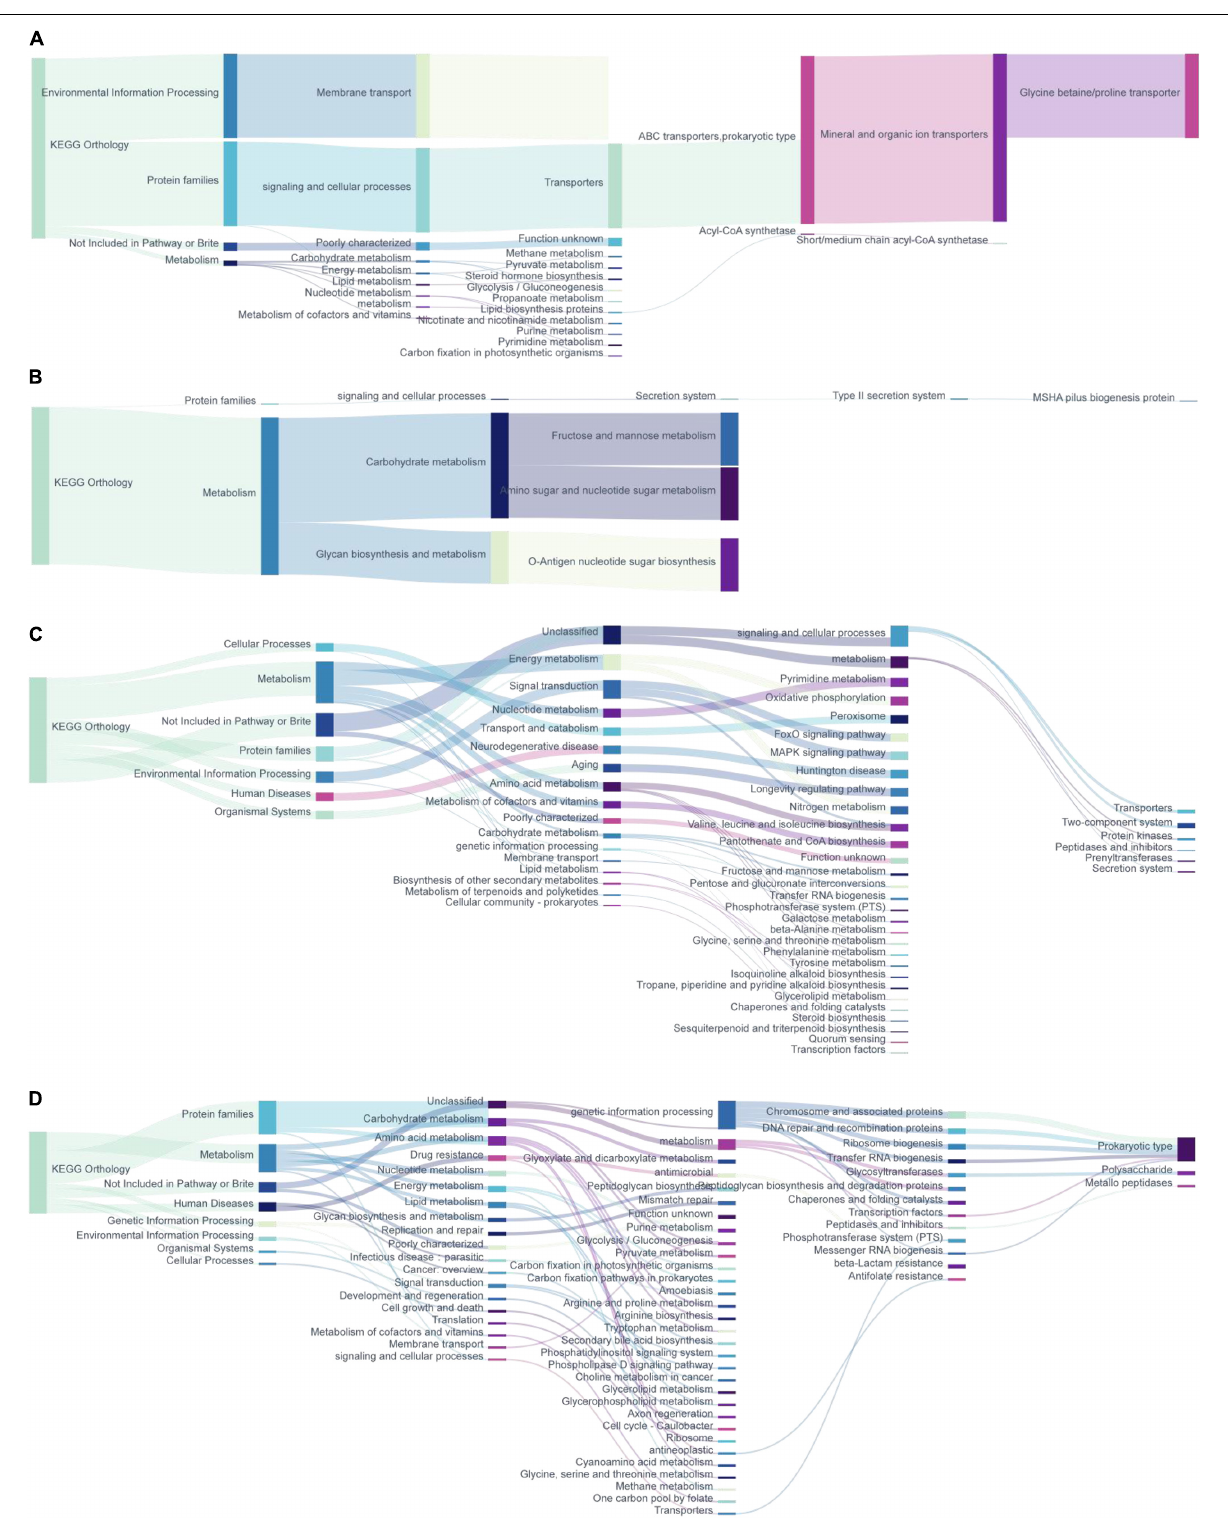
Frontiers in Microbiology |